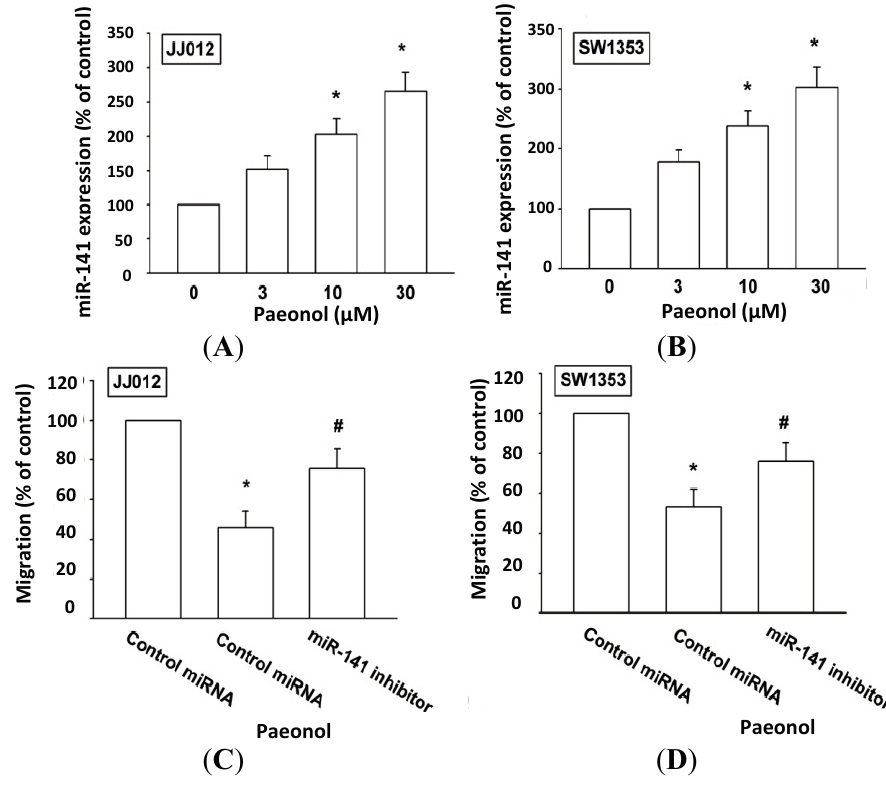
Figure 3. Paeonol increases miR-141 expression in chondrosarcoma cells. ( A , B ) Cells were incubated with various concentrations of paeonol for 24 h, miR-141 expression assessed by qPCR ( n = 6); ( C , D ) Cells were transfected with miR-141 inhibitor for 24 h, followed by stimulation with paeonol for 24 h, cell migration examined by Transwell ( n = 5). Results are expressed as mean ± S.E.M. * , p < 0.05 compared with control. #, p < 0.05 compared with paeonol-treated